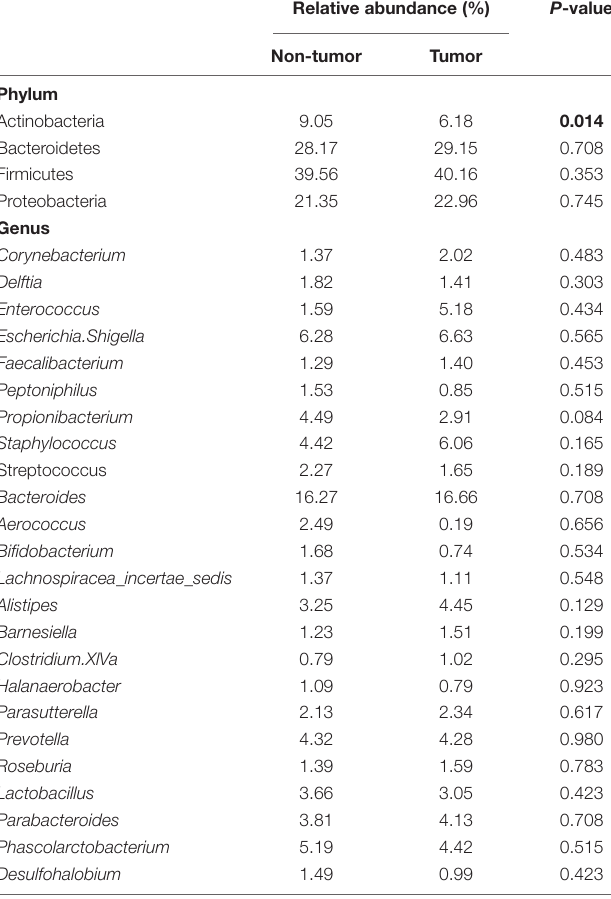
TABLE 3 | Differences in the relative abundances of taxa stratified by type of